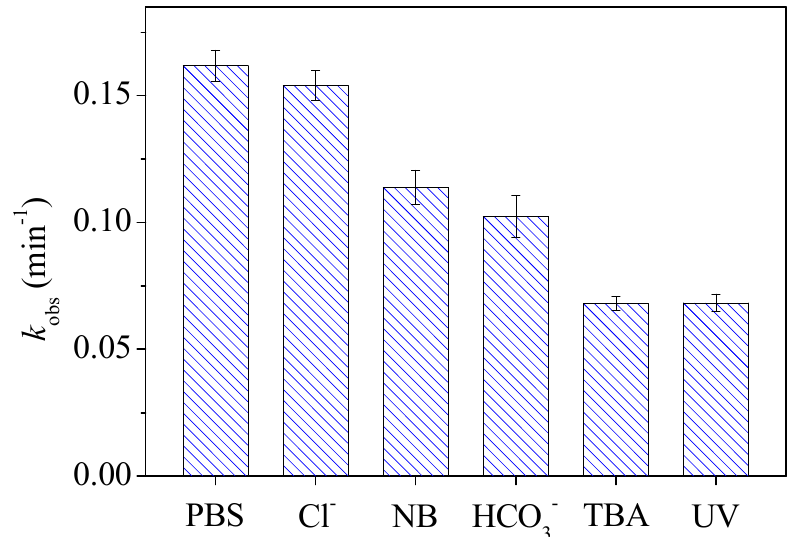
Figure 5. Observed degradation rate constant ( k obs ) of CTZ (10 µ M) in the presence of SRNOM (5 mg L − ) in UV/chlorine system ((Free chlorine) 0 = 100 µ M) under different conditions (PBS, pH = 7.0; (Cl − ) = 50 mM; (NB (nitrobenzene)) = 2 µM; (HCO 3− ) = 100 mM; (TBA ( tert -butanol)) = 100 mM) and in UV system as a control (the error bars represent the 95% confidence interval ( n = 3)).